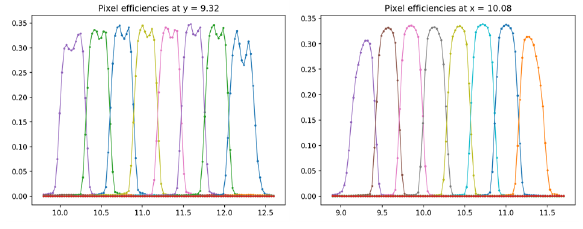
Figure 6. Vertial (left) and horizontal (right) scans of PMT22 from PDM2, λ = 405 nm.